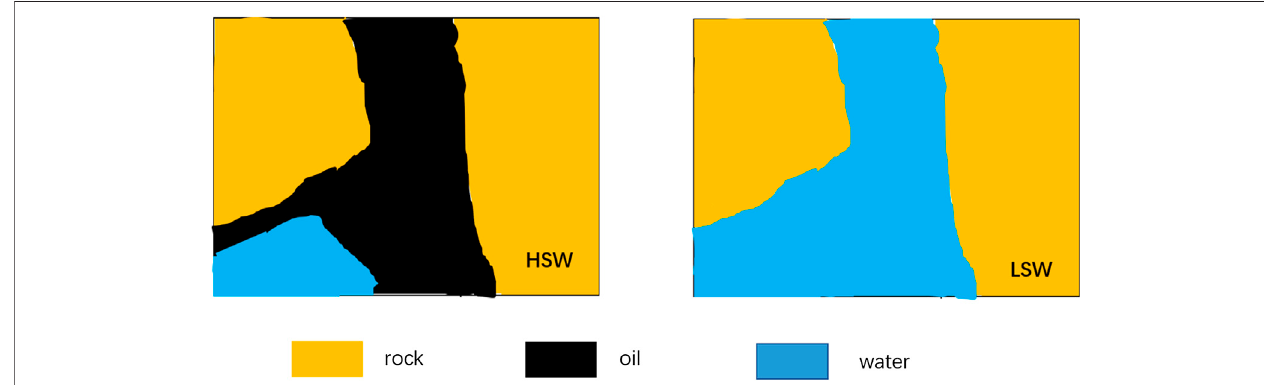
FIGURE 6 | Wetting properties of kaolinite model during high salinity water (HSW) and low salinity water (LSW).